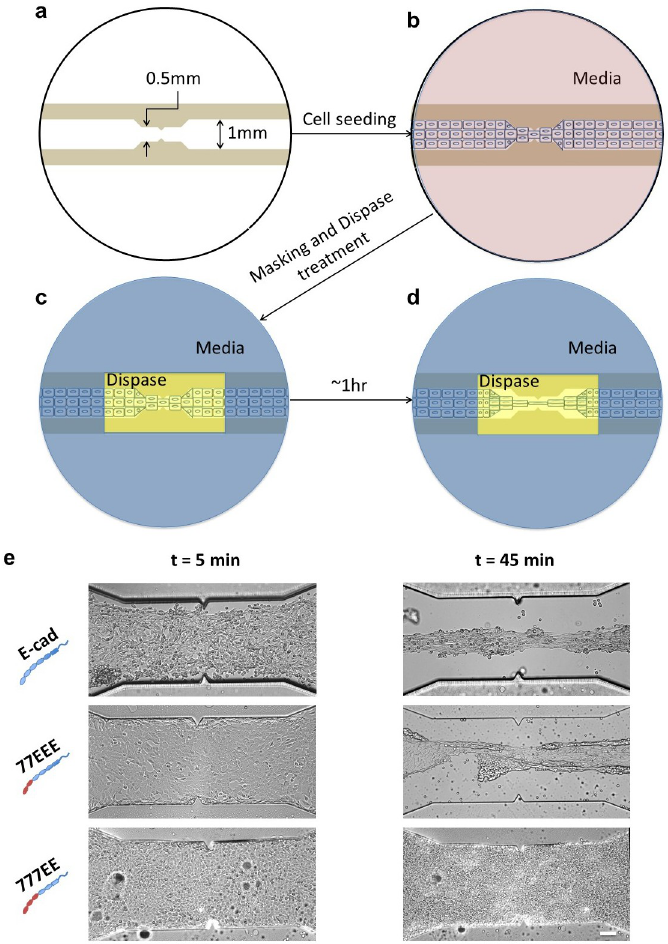
Fig 5. Dispase-based junctional protein tensor assay. (a) Schematic of a 1-mm wide channel with a central constriction of 0.5 mm made of UV curable polymer on a 27-mm glass-bottomed dish. (b) Channel seeded with cells forming cell-cell junctions. Fewer cells are shown here for ease of representation. (c) PDMS mask (blue) with a 5 mm × 2.5 mm opening in the middle that snuggly fits inside the dish. The media is removed from the opening and dispase (yellow) is added. The media remains in the area covered by the PDMS mask. (d) After ~1 hr of dispase treatment, cell-substrate bonds within the area are cleaved while the cells under the PDMS, where the culture medium is present, are still attached to the substrate. In the absence of cell-substrate adhesion, the cells that become lifted in the constricted dispase-treated region experience tension and stretch in the direction along the channel at the expense of cells contracting at either side of the constriction due to the intrinsic cortical tension of the cells. Figure not to scale. (e) E-cad-, 77EEE-, and 777EE-expressing S180 cells subjected to dispase treatment. Imaging was commenced 5 min after the addition of dispase for 1 hr. Note that, in the t = 45 min image, the E-cad-expressing cells have undergone significant strain yet the cell-cell contacts are still maintained. In the 77EEE-expressing cells, the cell sheet snaps when the sheet is lifted at lower strain levels as compared to E-cad-expressing cells. Although cell-cell junctions are formed similarly in 777EE- and 77EEE-expressing cells, 777EE-expressing cells are not able to maintain cell-cell contact in the absence of cell-substrate adhesion; they became single cells and cell clumps that are unable to withstand the tension as a cell sheet. Scale bar, 100 μ m.